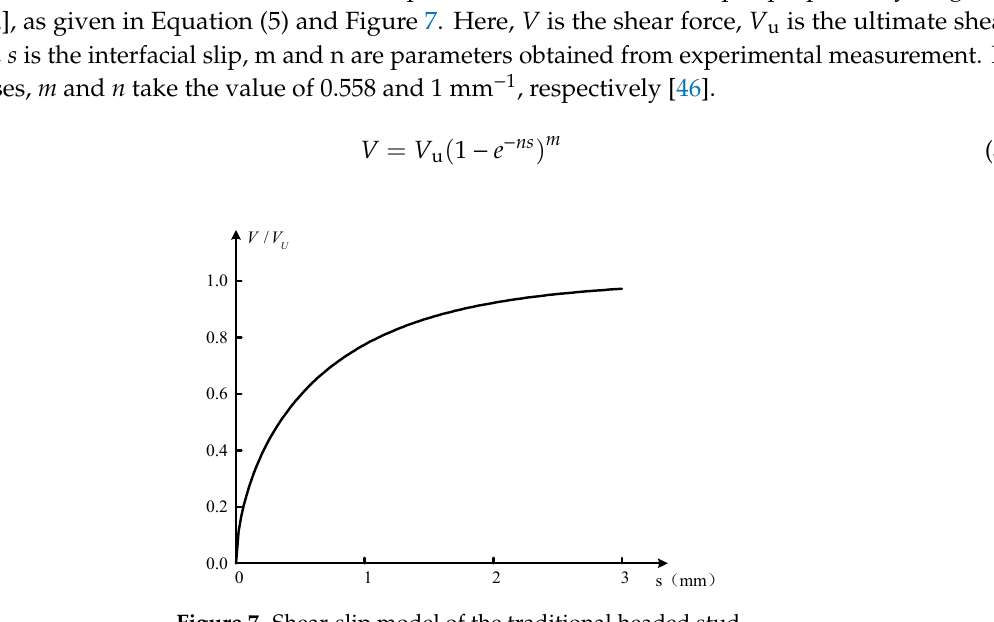
Figure 7. Shear-slip model of the traditional headed stud.